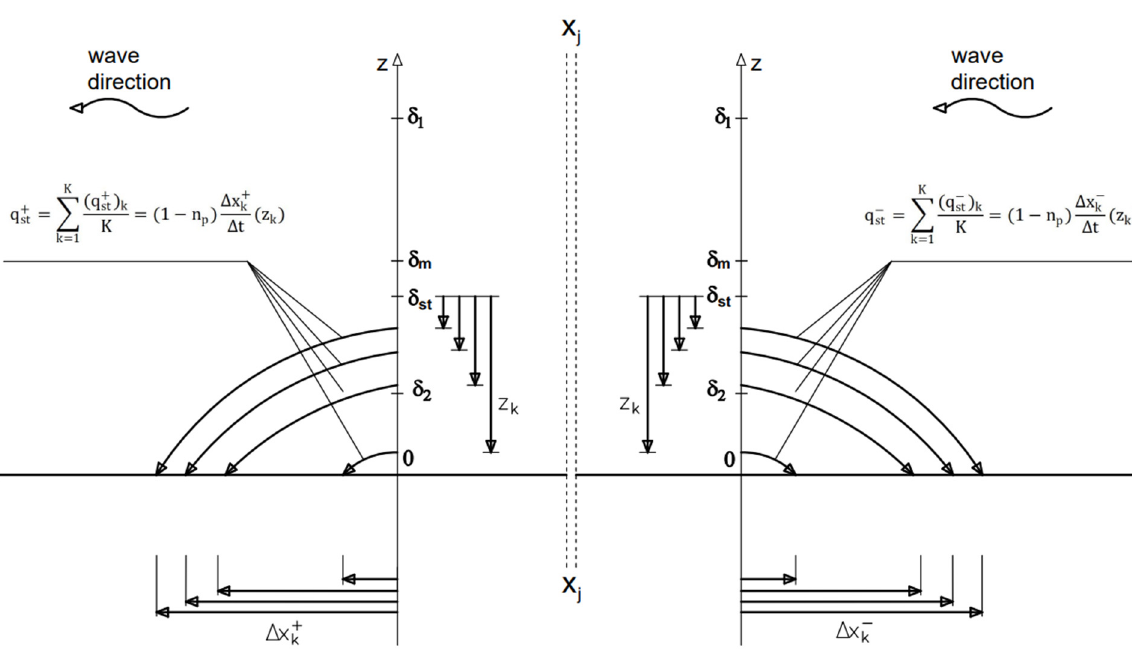
Figure 2. Sediment particle trajectories during the wave crest 𝑞 (cid:3046)(cid:3047)(cid:2878) and trough 𝑞 (cid:3046)(cid:3047)(cid:2879) sediment transport.